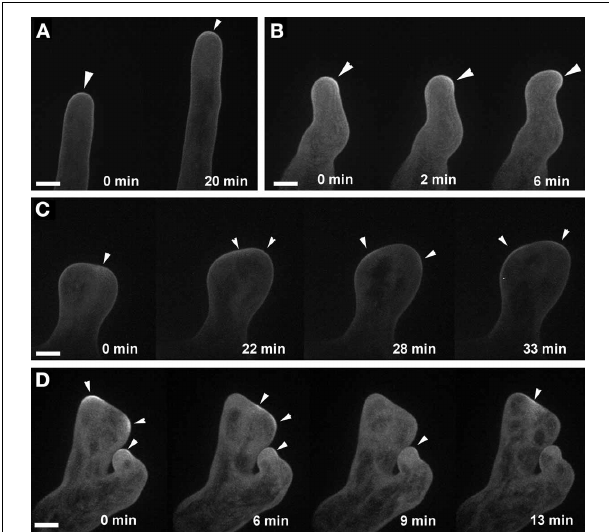
FIGURE 5 | ROP2 localization to the apical cell membrane of root hairs is altered in ark1 . (A) A wild-type root hair shows enhancement of EYFP-ROP2 at the apical plasma membrane (arrow heads). (B) In a wavy root hair of ark1 , plasma membrane localized EYFP-ROP2 shifts position prior to the change in root hair growth direction (arrowheads). (C,D) In ark1 root hairs that swell and form branches, EYFP-ROP2 signal appears to become enriched at more than one location within the cell. Also, the EYFP-ROP2 signal dissipates then shifts to a different plasma membrane domain (arrowheads). Time-lapse movie sequences of still images in panels (A , C) are presented as Movies S4 (for wild-type) and S5 (for ark1 ), respectively. Bars = 20 μ